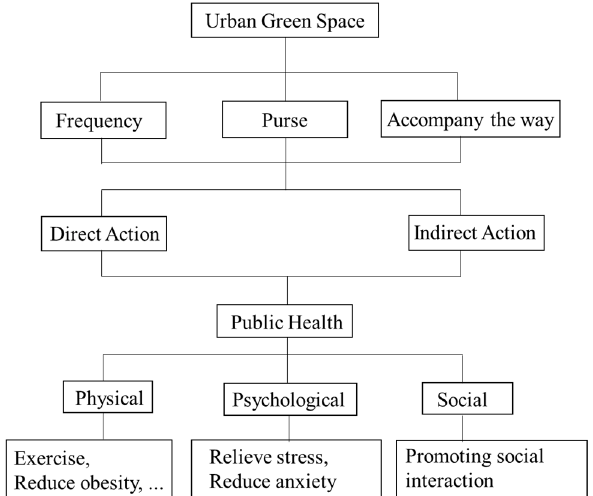
Figure 5. The relationship between the